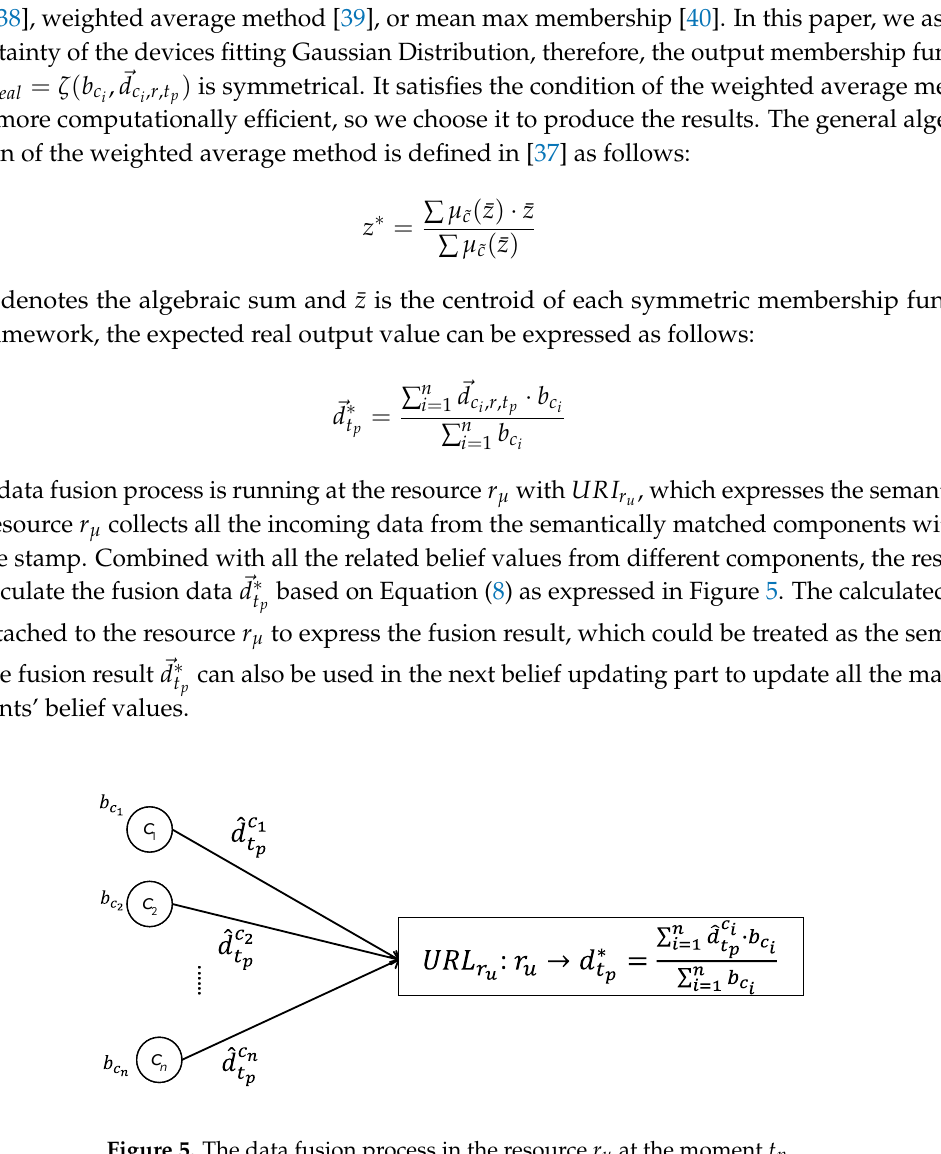
Figure 5. The data fusion process in the resource r u at the moment t p